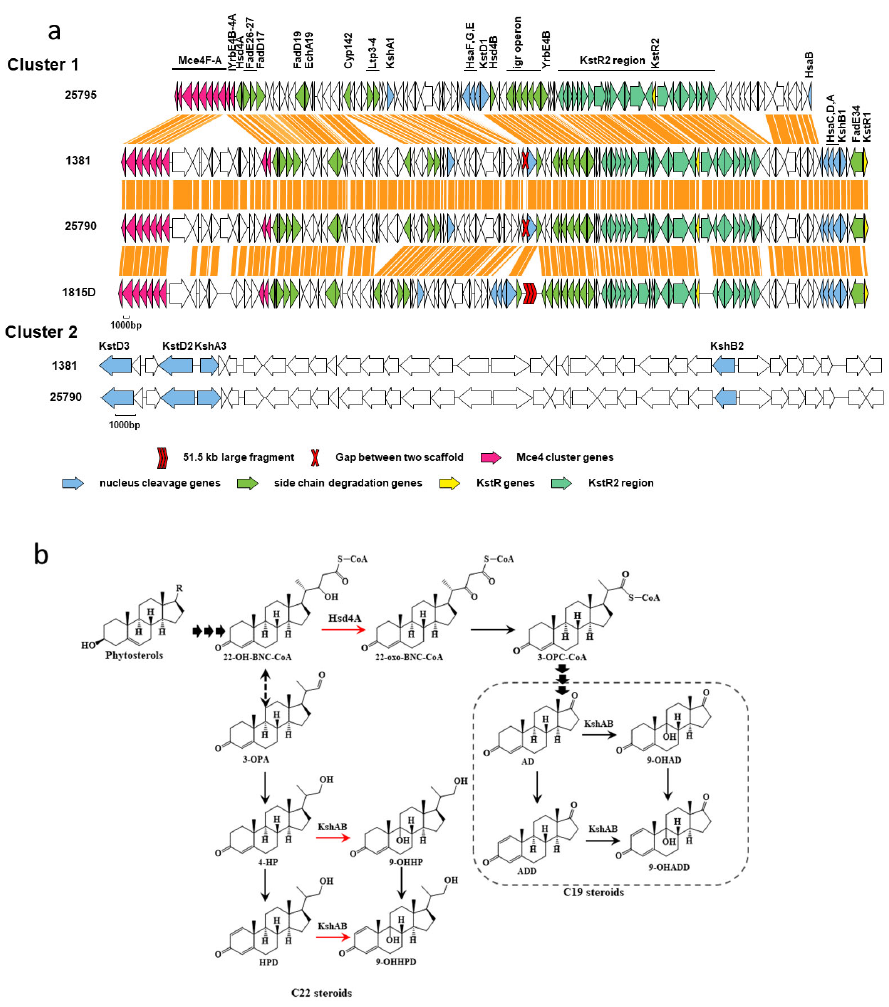
Figure 3. Partial gene cluster encoding the catabolism of sterols in M. neoaurum DSM 1381and putative phytosterol metabolic pathway by M. neoaurum DSM 1381. ( a ) Genes in the map are color-coded according to assigned or proposed function: Orange, mce cluster genes for steroids transportation; Green, side-chain degradation genes; Blue, nucleus cleavage genes; Light green, the genes under the control of KstR2; Yellow, the gene encoding the transcriptional repressor KstRs; ( b ) The red arrow indicates the step blocked in M. neoaurum DSM 1381.